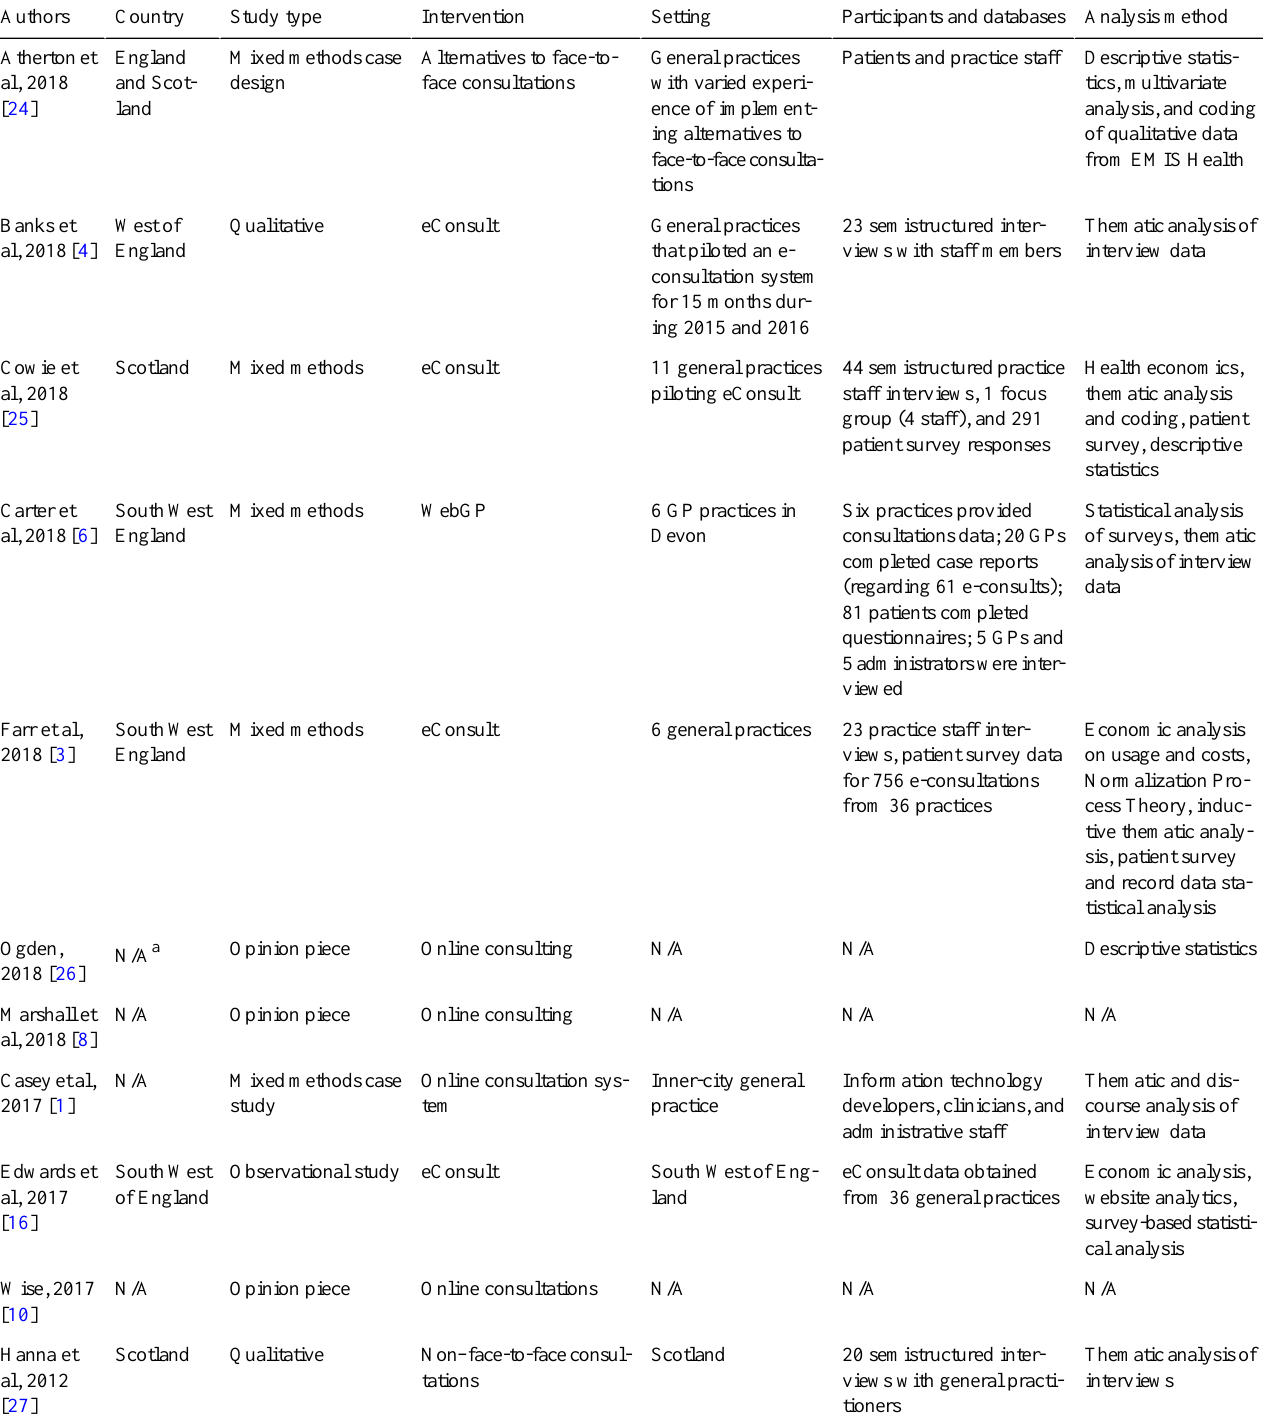
Table 1. Characteristics of included